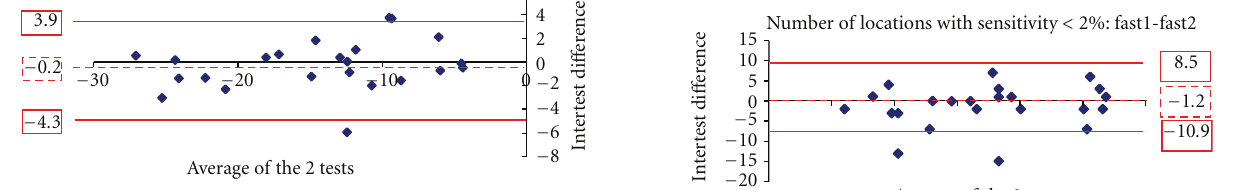
Figure 3: The Bland-Altman plot showing agreement in mean deviation between the first and second visit 10-2 SITA fast tests. The dashed line marks the average di ff erence between the two algo- rithms. The solid lines mark the upper and lower limits of the 95% limits of agreement.